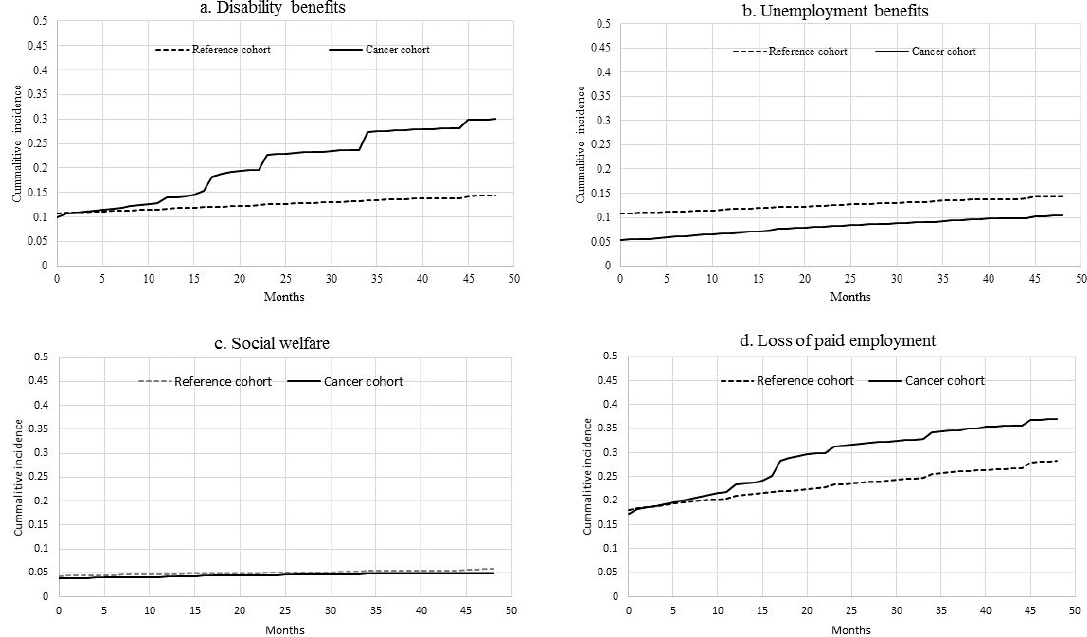
Figure 2. Cumulative incidences for ( a ) disability benefits, ( b ) unemployment benefits, ( c ) social welfare and ( d ) loss of paid employment for the cancer survivor cohort and the reference cohort.